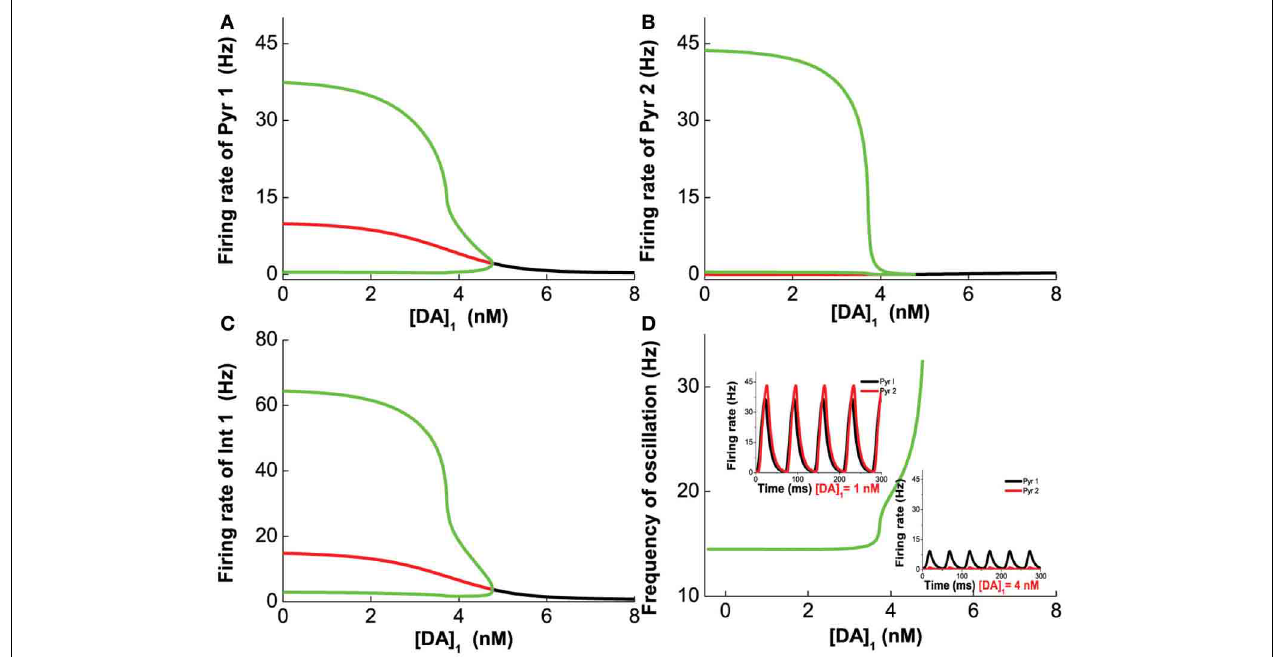
FIGURE 10 | D1 selective agonist/antagonist on the heterogeneous network. Increasing [DA] 1 will decrease the amplitude of oscillation but increase the frequency of oscillation. (A) Dependence of firing rate of pyramidal cell (D1 + 5-HT1A) on [DA] 1 . The amplitude of the oscillation, the difference between the green lines, decreases with increasing [DA] 1 . (B)